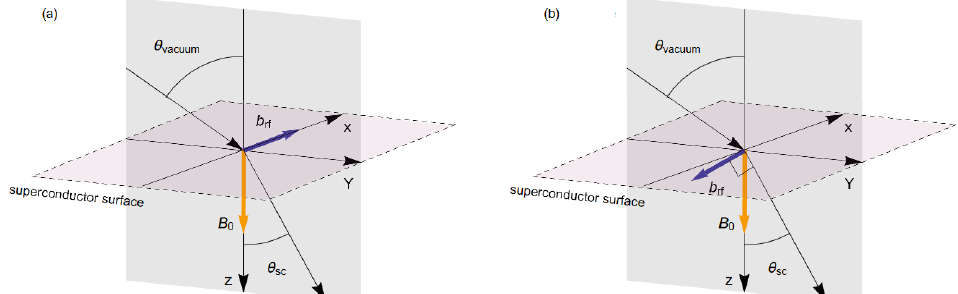
Figure 1. Light propagation in ( a ) TM mode and ( b ) TE mode from a vacuum to a superconductor. The yz -plane is the plane of incidence. The external magnetic field B 0 is perpendicular to the surface of the superconductor. The magnetic field of the light B in TM mode is perpendicular to the plane light of incidence. Conversely, the electric field of the light is perpendicular to the plane of incidence, and the magnetic field exits at the yz